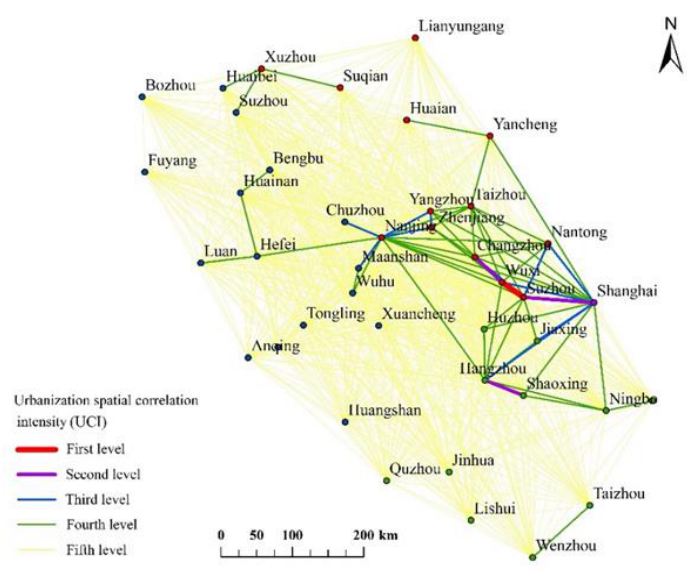
Figure 4. Spatial urban correlation intensity (UCI) map of urbanization in the YRD region.